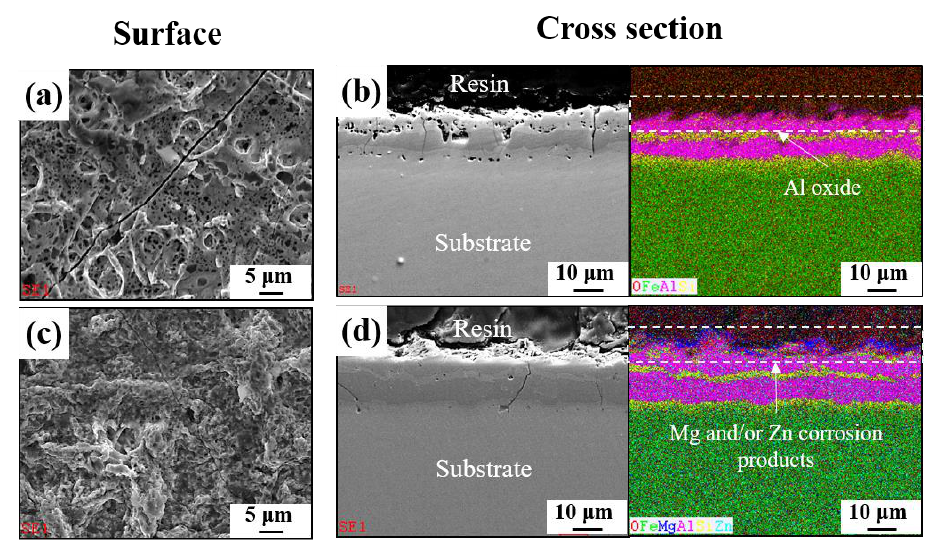
Figure 7. Surface and cross-sectional observations with EDS mappings of ( a , b ) AlSi-MC and ( c , d ) AlSiZnMg-MC after the potentiostatic (PS) test.